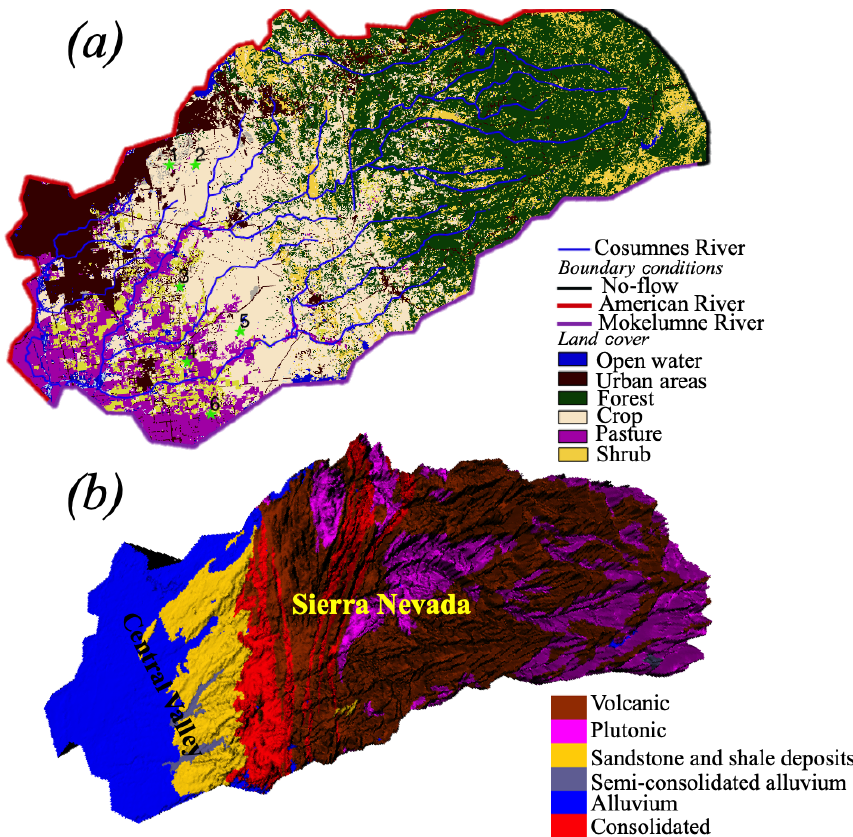
Figure 1. (a) Land use and land cover (Homer et al., 2015) and (b) geology (Jennings et al., 1977) and topography (United States Geological Survey, USGS) of the Cosumnes